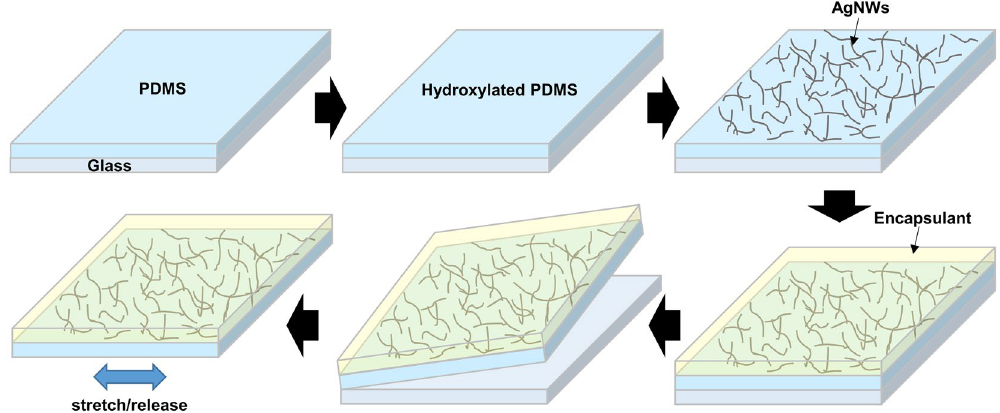
Figure 1. Schematic illustration of the fabrication of crack-induced strain